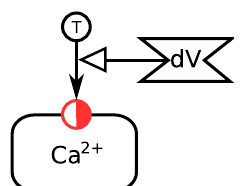
Figure 2.35: Using the state variable existence to represent the appearance of calcium fol- lowing a depolarisation.